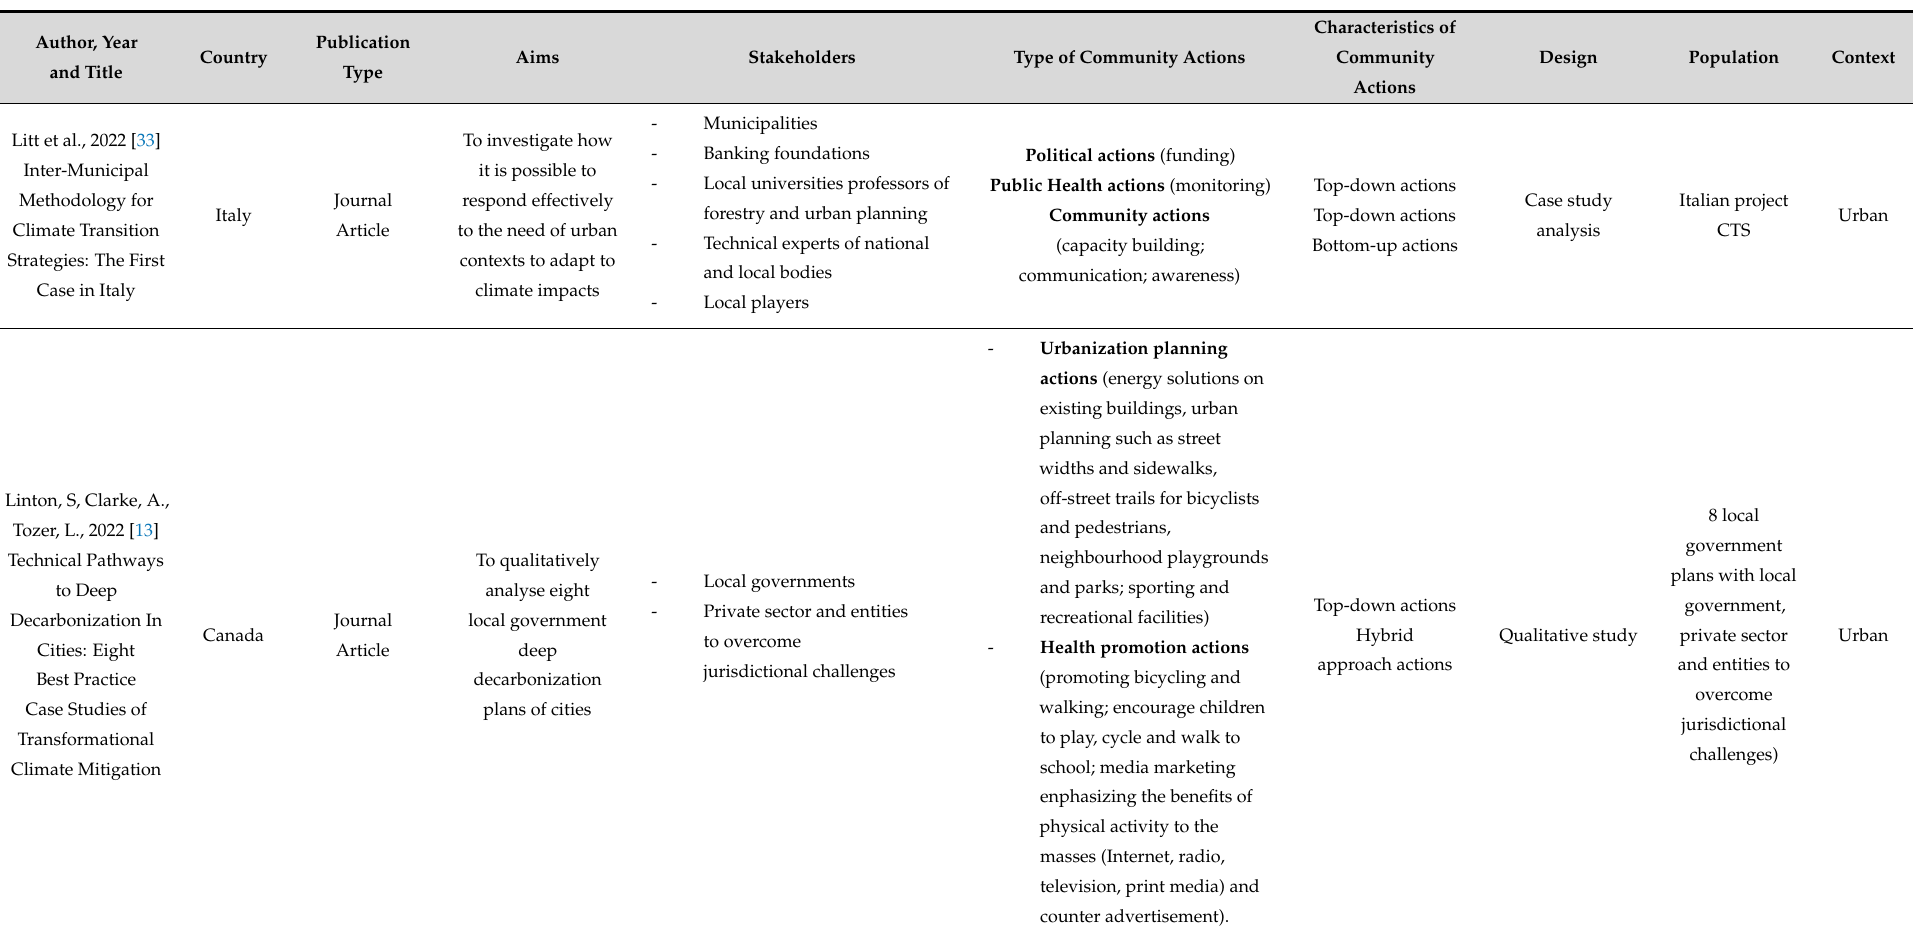
Table A3. Data Extraction Tool with the Characteristics of the Studies